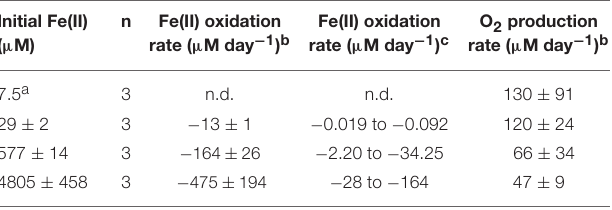
Values indicate the average of biological replicates ± standard error (SE). a Fe(II) added from trace element solutions. b Rates were determined from linear regression of three data points with the steepest slopes. c Rates were determined from Equation (1) and the maximum range for all biological experiments and instantaneous Fe(II) and O 2 measurements at a certain initial Fe(II) concentration. n.d., not